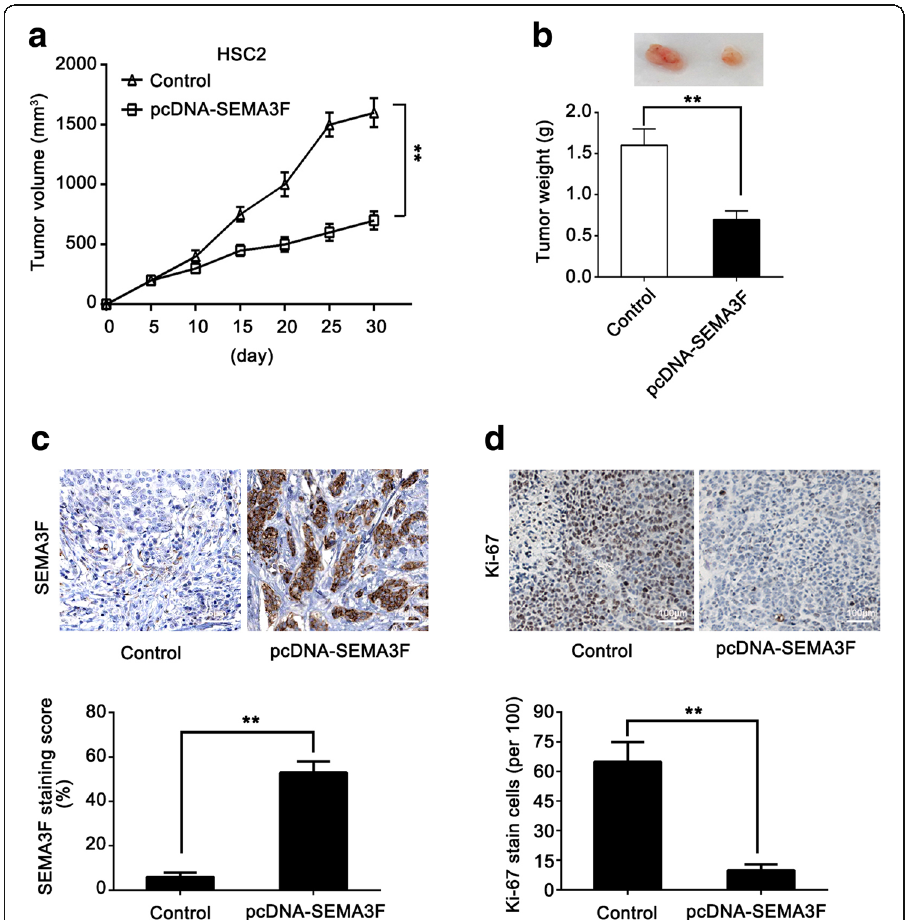
Fig. 4 Effect of SEMA3F expression on the progression of oral cancer in vivo. a – HSC2 cells transfected with pcDNA-SEMA3F were transplanted into nude mice. The growth curve and average weight of tumors are shown. b – HSC2 cells transfected with the control were transplanted into the nude mice. The growth curve and average weight of tumors are shown. c – The expression of SEMA3F was tested using IHC analysis in tumor tissues from the nude mice. The scale bar is 75 μ m. d – The expression of Ki67 was tested using IHC analysis in tumor tissues from the nude mice. The scale bar is 100 μ m. ** p <0.01 as compared with the